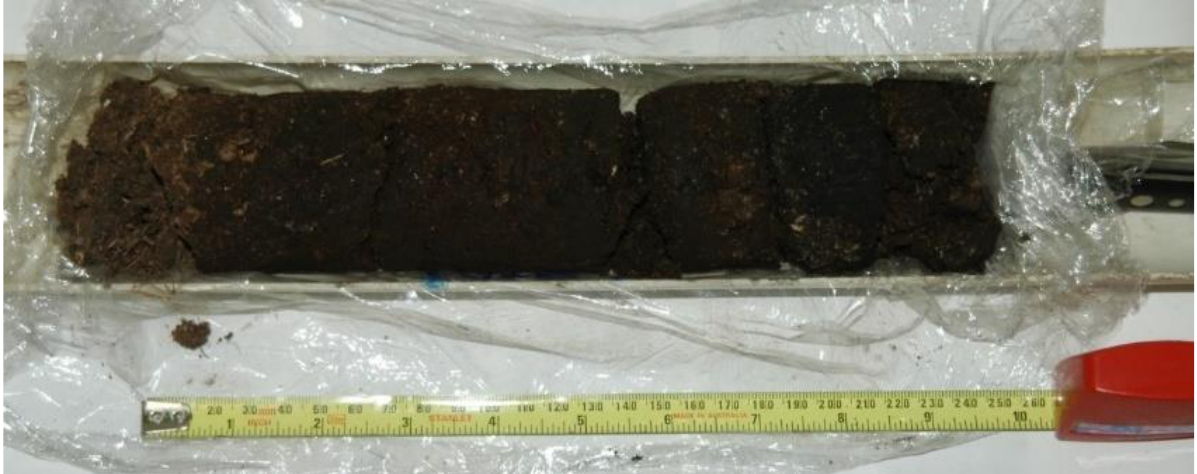
Figure 4. Bogong Peaks (BP2) core, illustrating the homogeneous nature of the sediment. Table 1. Moisture and organic matter contents (as LOI, dry weight basis) of bulk and fractionated aestivation site deposits. Moisture loss was calculated on the basis of drying bulk samples at 110 °C; LOI=loss on